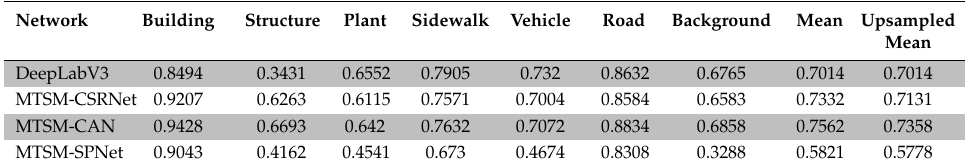
Table 2. Per-category intersection-over-unions (IoUs) and means for DeepLabv3 and our MTSM models trained on TH2020.